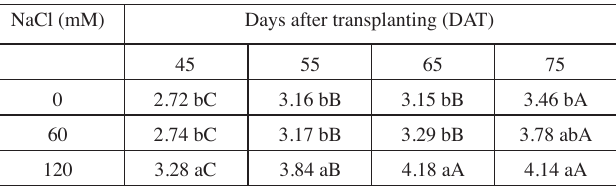
Fig. 1: Effect of NaCl on root, stem, leaf and plant dry weight of cape gooseberry at 75 DAT. Bars indicate ±SE.